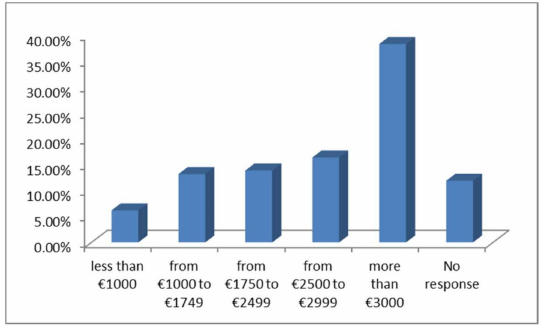
Figure 2. Sample distribution by monthly household income.